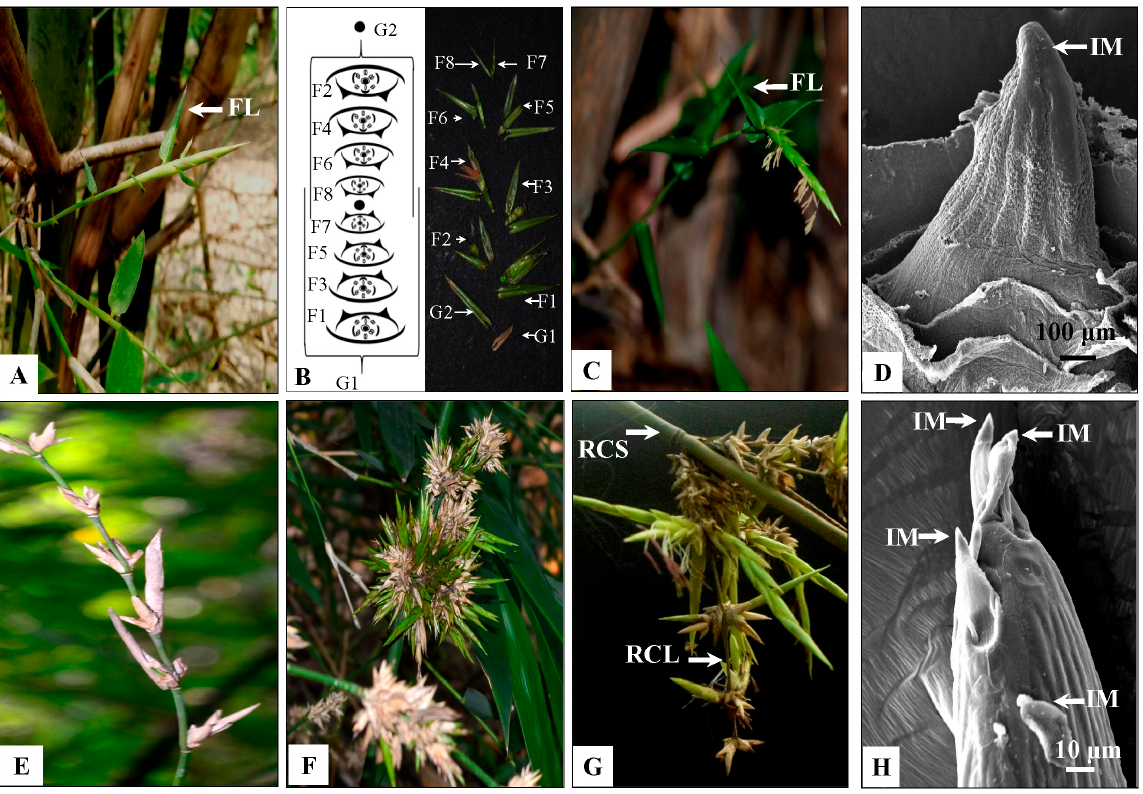
Figure 3. Morphological observation and Scanning electron microscopy (SEM) of the inflorescence of B. tulda . ( A ) Solitary spikelet from the lateral branch. ( B ) Organisation of a solitary spikelet. ( C ) Solitary spikelet from a rhizome as a tiller. ( D ) SEM images of spikelet with single inflorescence meristem. ( E ) Pseudospikelet. ( F ) Pseudospikelet in a capitate form. ( G ) Rachis (RCS) and rachilla (RCL) of pseudospikelet. ( H ) SEM images of pseudospikelet with multiple inflorescence meristem. Abbreviations used: FL—Flag leaf, IM—Inflorescence